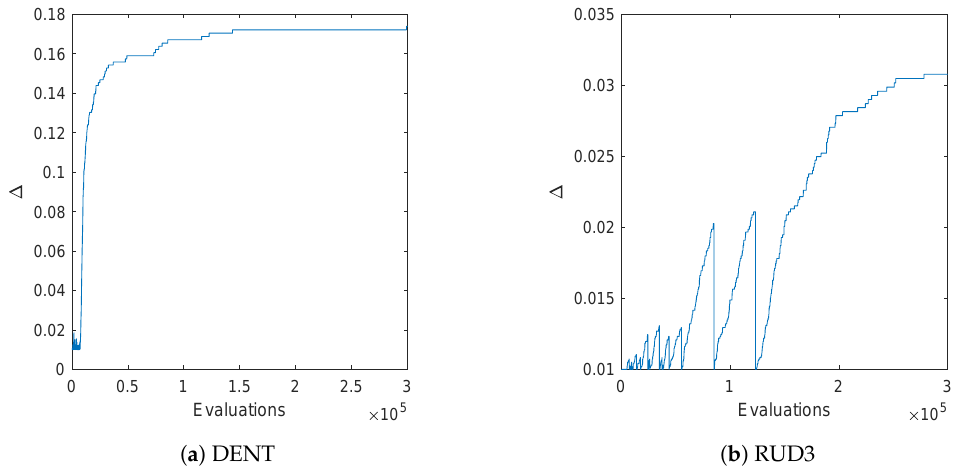
Figure 6. Evolution of the value of ∆ for one run of the algorithm on DENT and